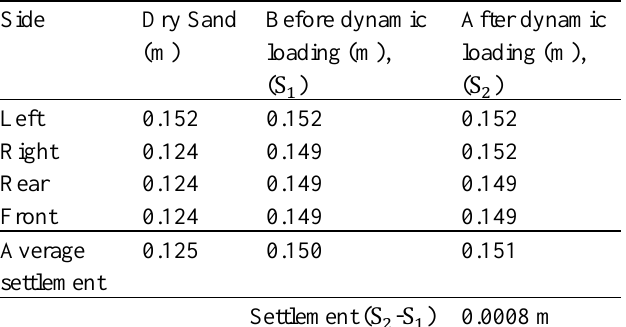
Settlement of Ground from Sides of the Structure in Treated 1-g Physical Model-III with Treatment beneath the Structure